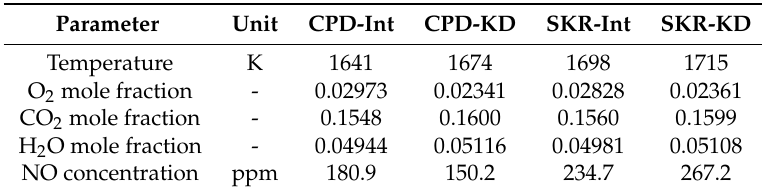
Table 10. Area weighted averaged value at the